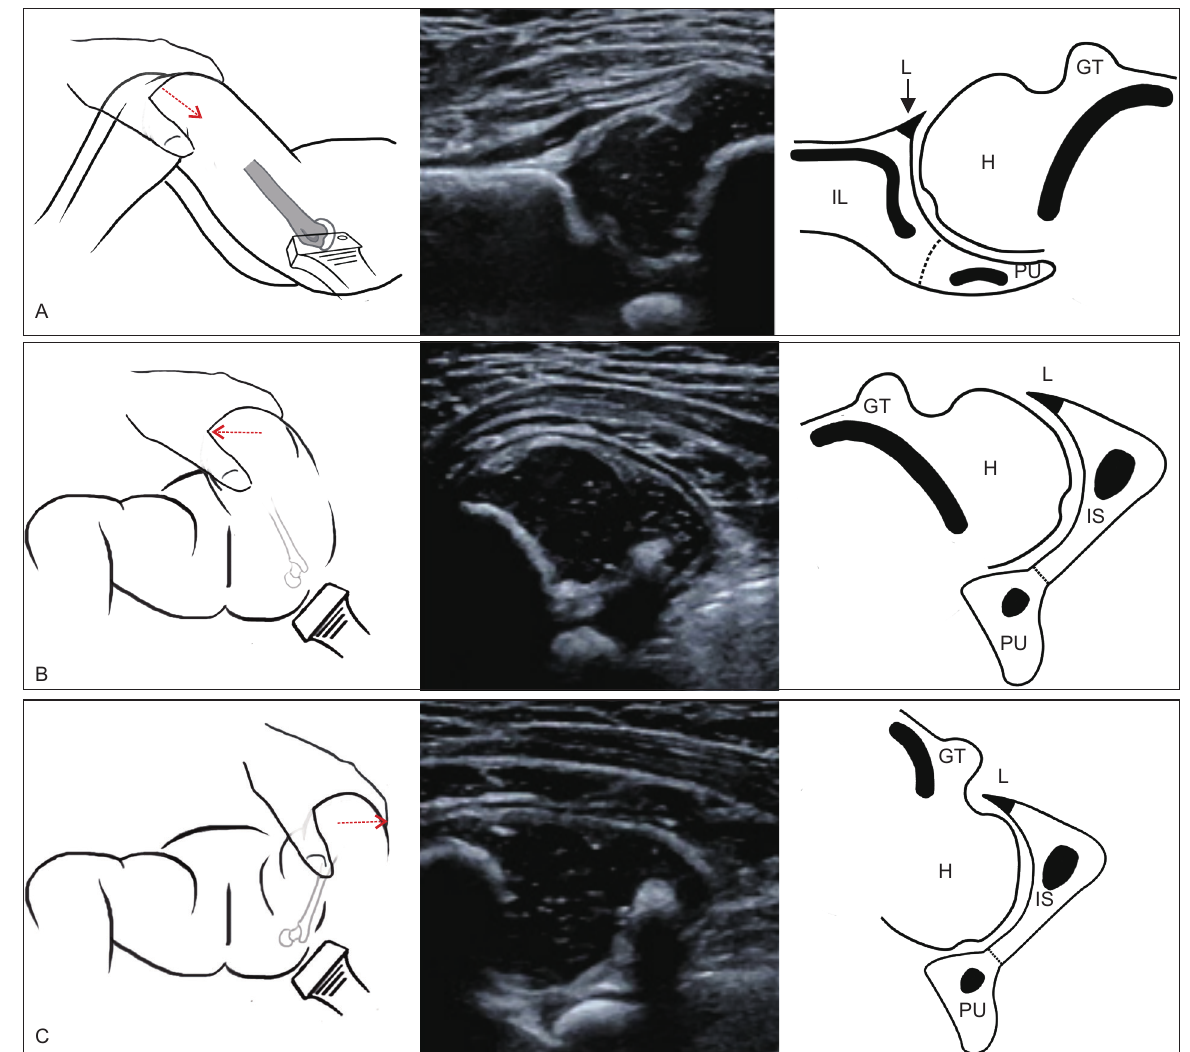
Figure 4 Hip ultrasound of the body position, standard image and anatomic illustration. (A) Axial stability test; (B) Adduction stability test; (C) Abduction stability test. IL, ilium; PU, pubis; IS, ischium; H, femoral head; GT, greater trochanter; L,